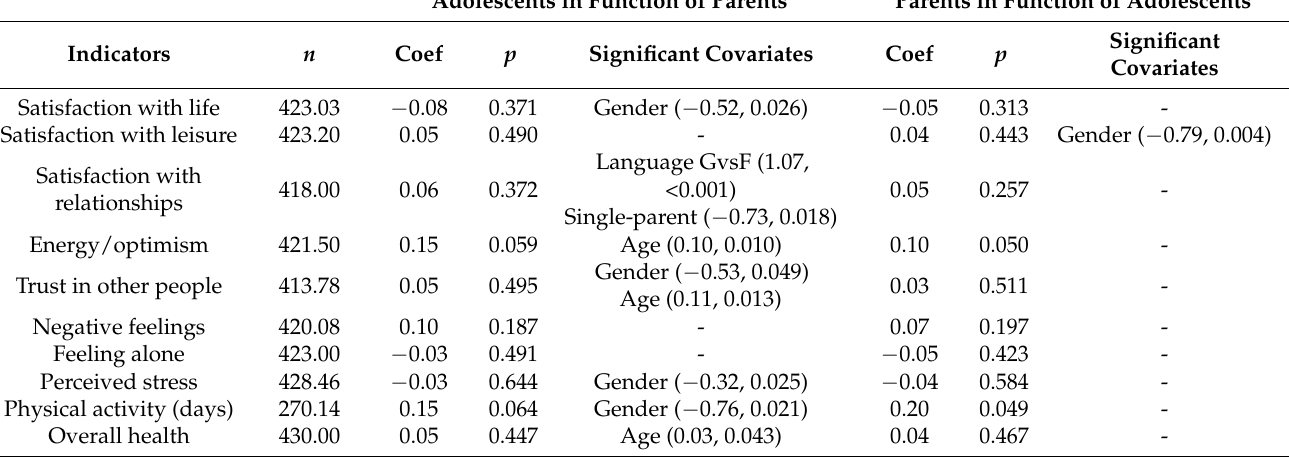
Table 3. Regression models for the explanation of the evolution of an indicator of the adolescents in function of the same indicator among their parents, including control variables. The right part of the table provides the same computation for the indicators of the parents. For each significant covariate, we provide the coefficient and the p